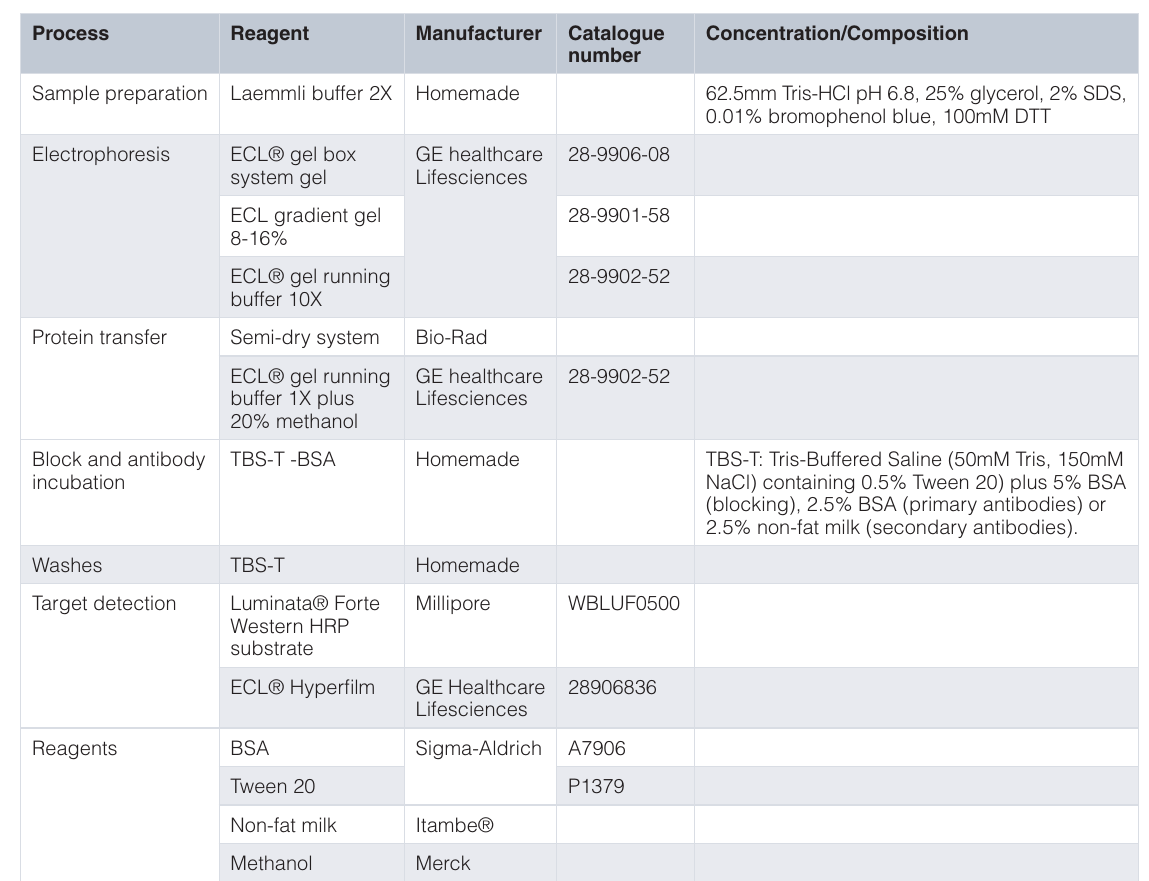
Table 1. Reagents for western blots.